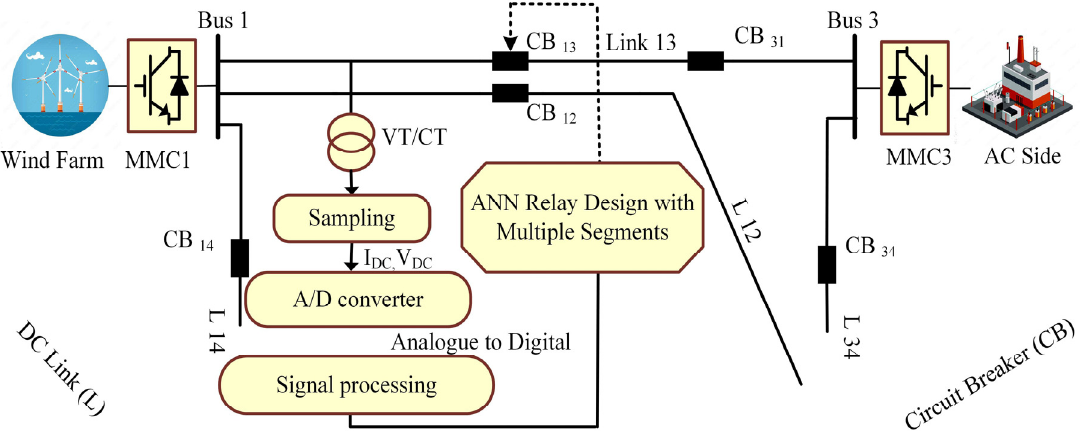
Figure 9. Protection system proposed for the scheme.